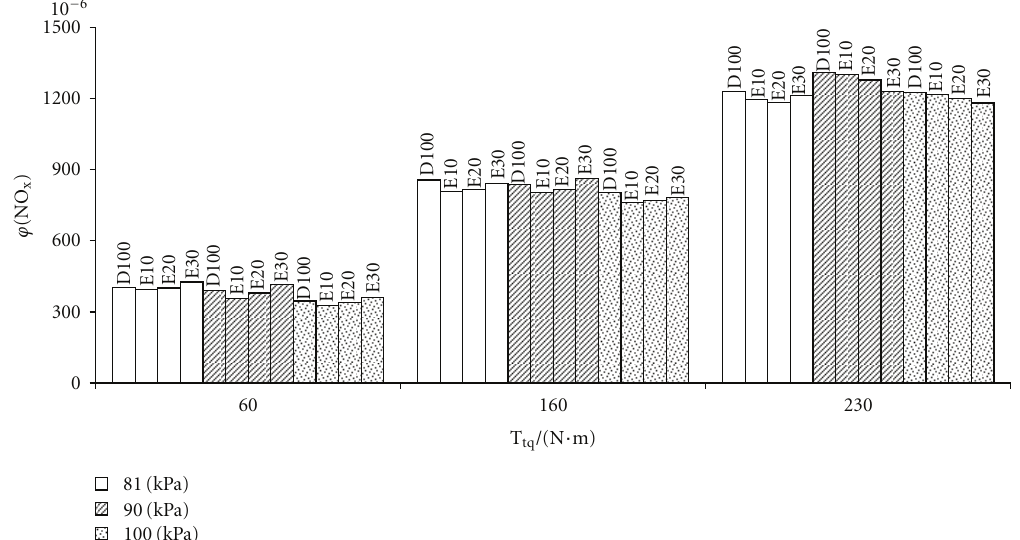
Figure 9: Comparison of NO x emission of di ff erent atmospheric pressure and mix proportion at speed 2200 r/min.